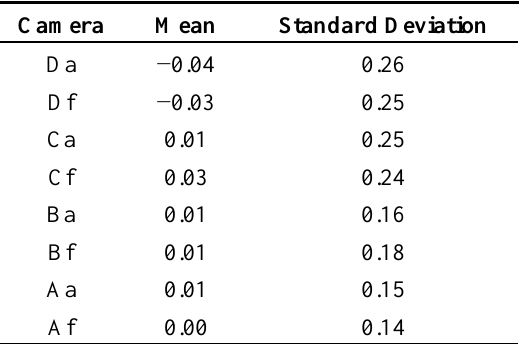
Table 1. Camera co-registration